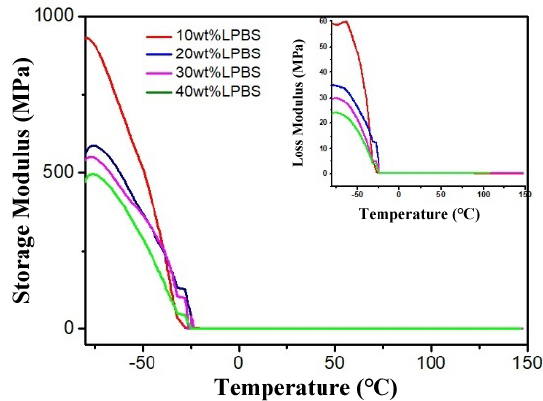
Figure 5. Storage moduls (G ’ ) of LPBS/MVQ samples at 1 Hz, the insert curve is corresponding loss moduls (G ’’ ) of LPBS/MVQ samples at 1 Hz.